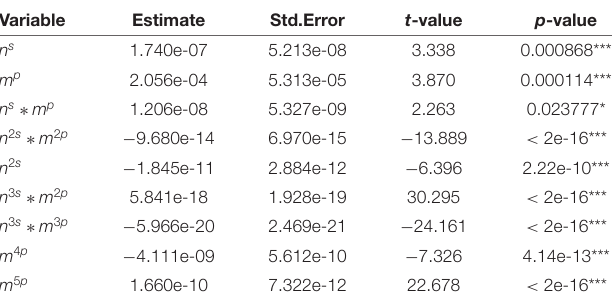
TABLE 7 | Summary statistics for selected variables in finite sample size between 201 and 300. Variable